Question: Briefly state, in one sentence, what is plotted here.
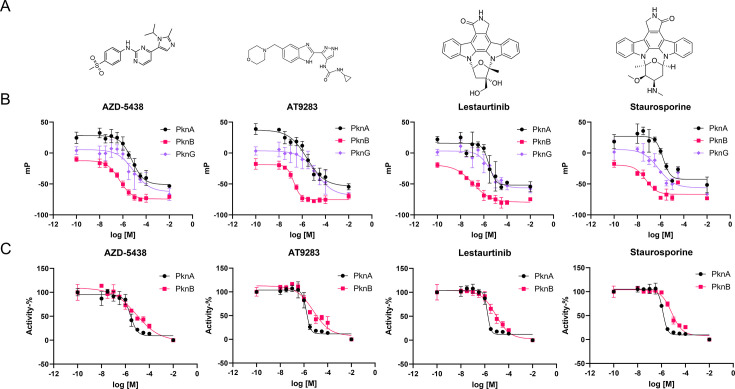
Answer: In vitro assay results. ( A ) Structures of the compounds. ( B ) Dose-response (IC 50 ) curves of the tested compounds against individual kinases, measured with fluorescence polarization ( n = 1); bars represent standard deviation of a triplicate measurement. mP, millipolarization. ( C ) IC 50 curves of the compounds with PknA and PknB, measured with the kinase activity assay ( n = 1); bars represent standard deviation of triplicate measurements.